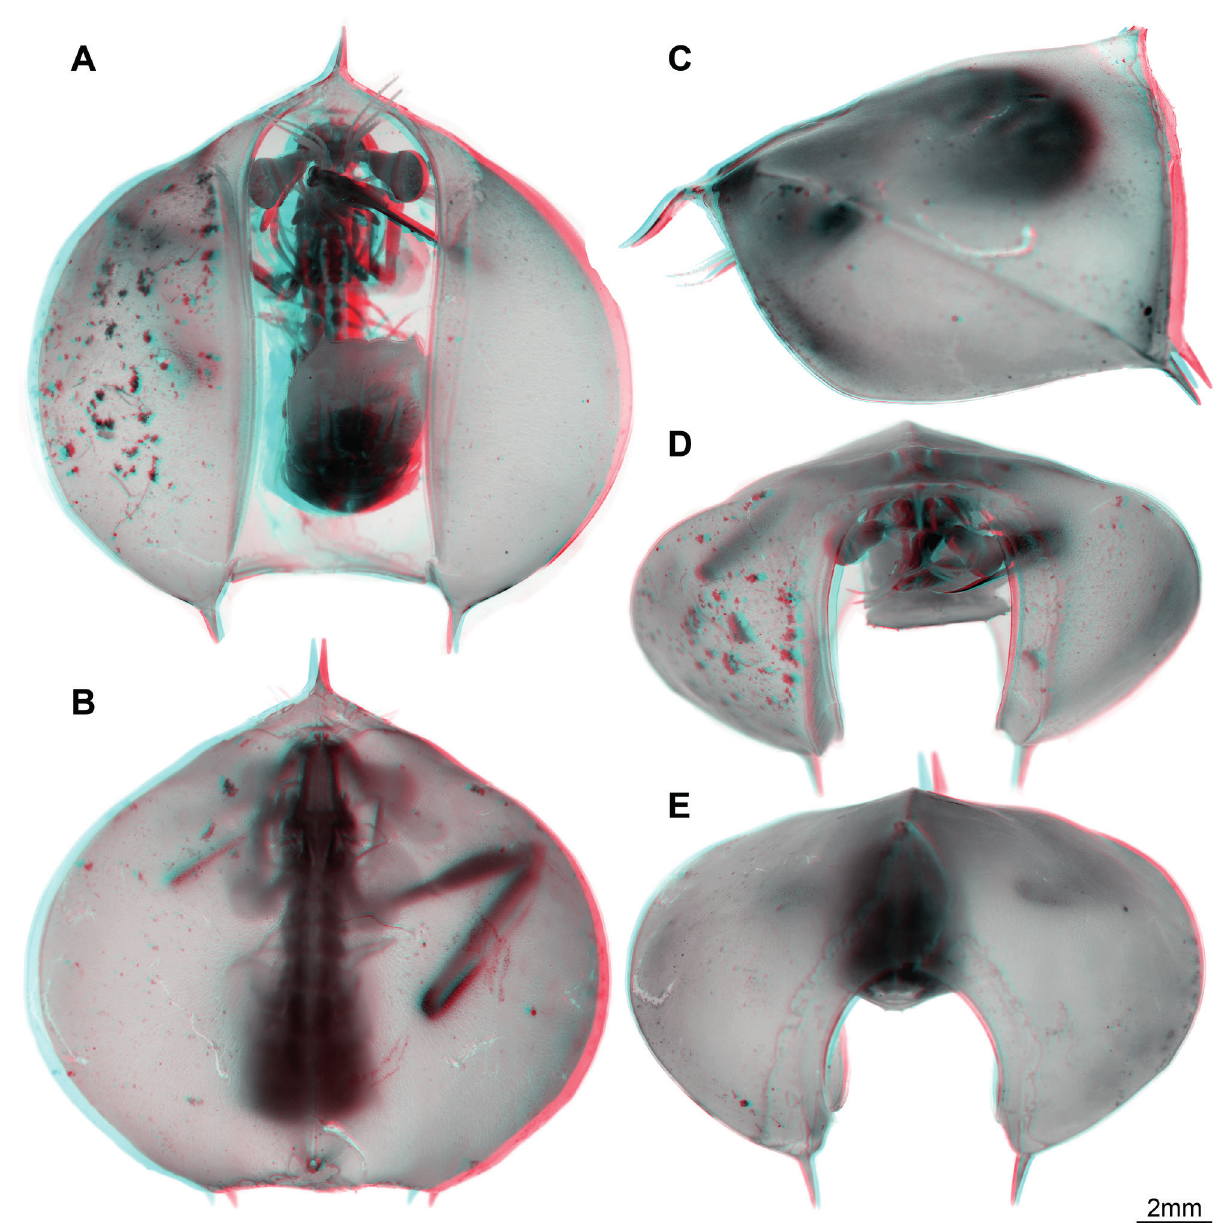
Figure 3. Red-cyan stereo-anaglyph images of ZMUC-CRU-8662; smaller specimen of “balloon-larva”. Please use red-cyan glasses to view, red left, cyan right. A. Ventral view. B. Dorsal view. C. Lateral view. D. Frontal view. E. Posterior view. All images inverted for enhancing